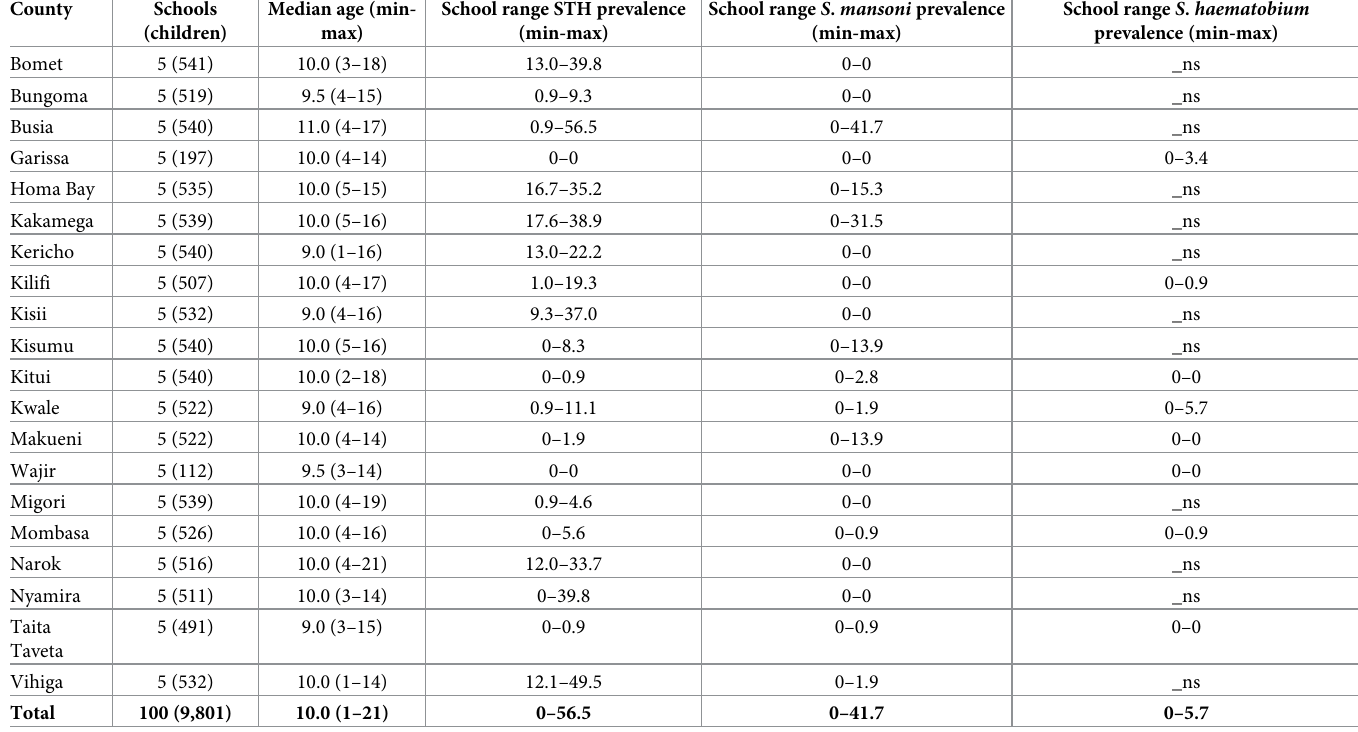
Table 1. Number of schools and children examined by county as well as school prevalence range (min—max) among school children in Kenya after five rounds of MDA.